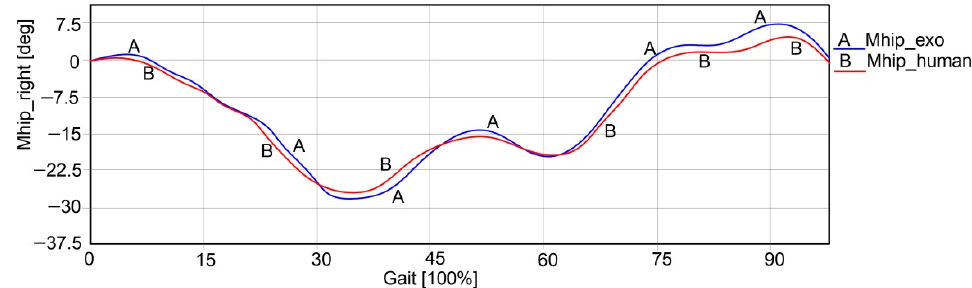
Figure 31. Right hip angular variation exoskeleton vs. human subject during a complete gait.